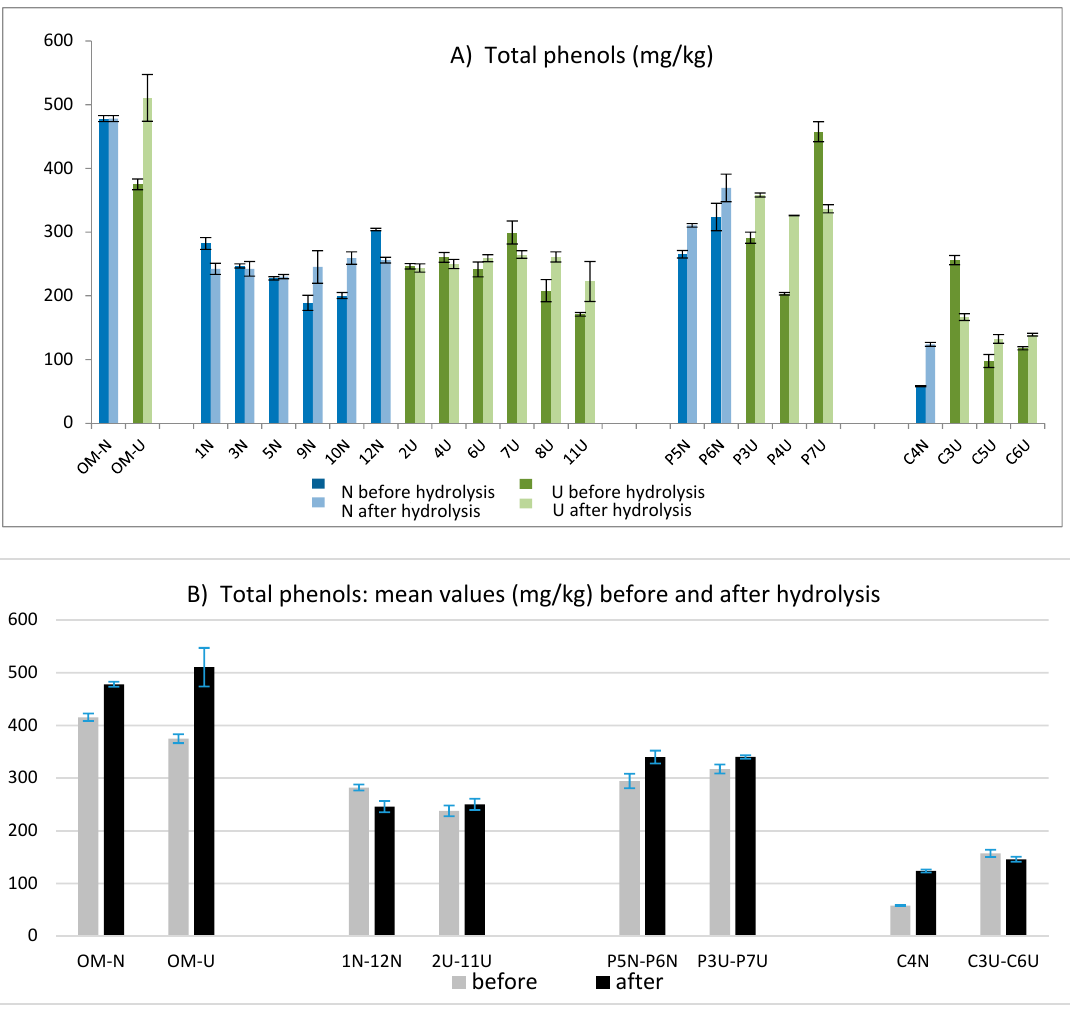
Figure 3. Total phenols obtained before and after the acidic hydrolysis for each EVOO ( A ) and averaged over all oils obtained in each oil mill ( B ).